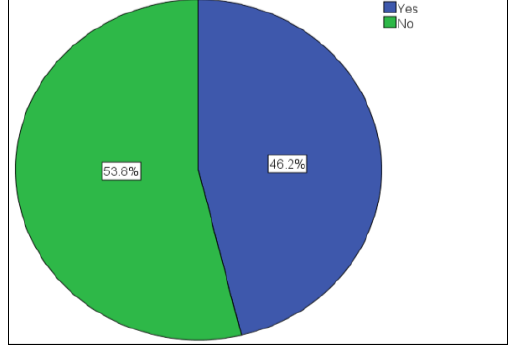
Figure 3: Respondents Statuses on Training on Food Safety Program; Source: Author,